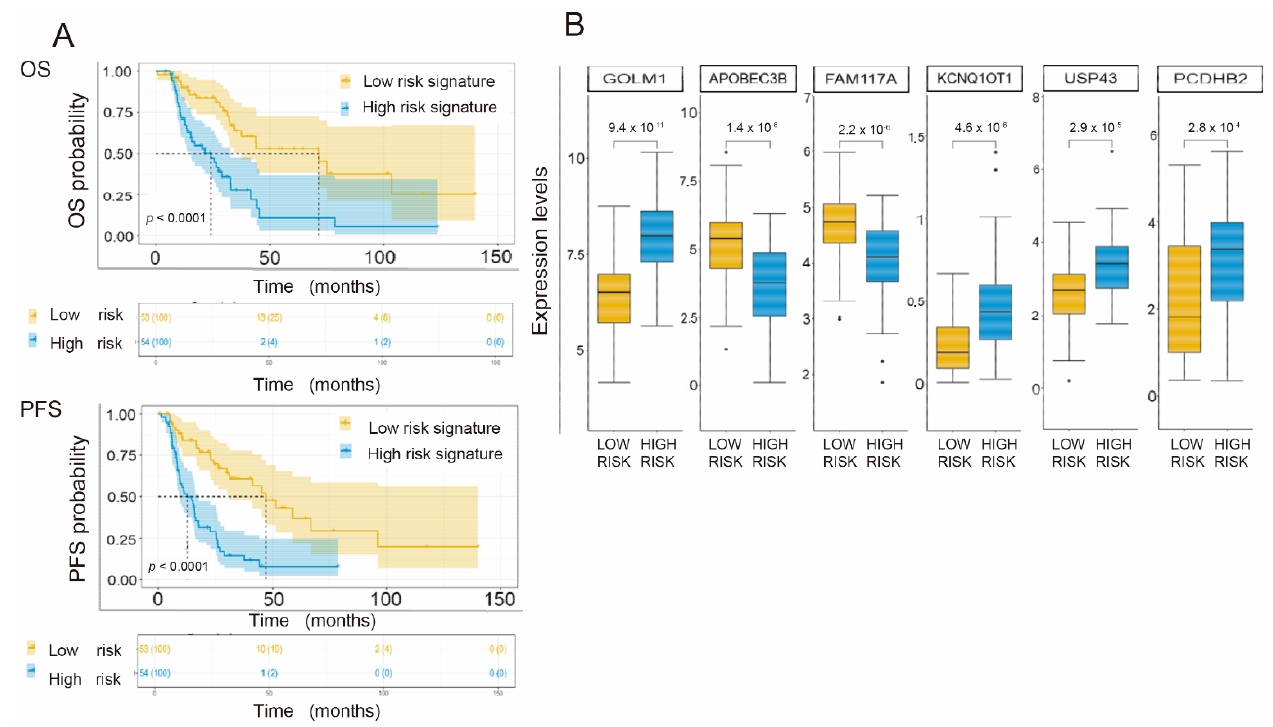
Figure 5. ( A ). Common signature of six genes for OS and PFS. Kaplan–Meier curves in which the probability of OS (OS) and PFS (PFS) is presented as a function of the risk group of the proposed firm (low or high risk). ( B ). Box plot showing the expression levels (logTPM) on the ordinate axis of each gene as a function of each prognostic group (low or high risk). *, p < 0.05; **, p < 0.01.